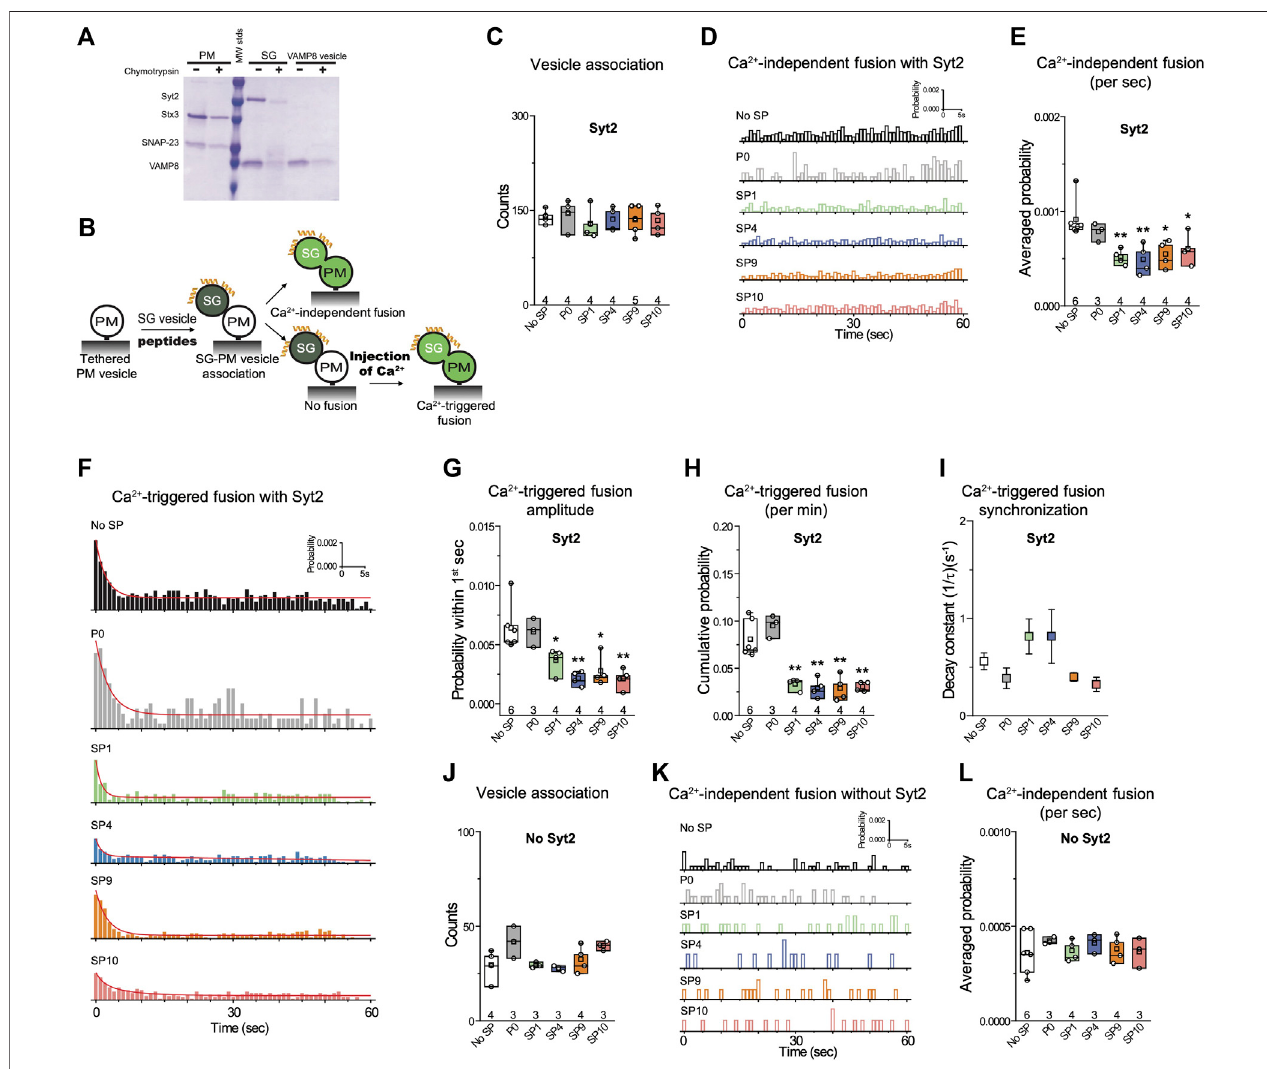
FIGURE 5 | Stapled peptides inhibit Ca 2+ -triggered content mixing with reconstituted airway epithelial SNAREs and Syt2. (A) SDS-PAGE of airway PM and SG vesicleswithreconstitutedairwaySNAREsandSyt2.Achymotrypsindigestwasusedtodeterminetheproperdirectionalityofthereconstitutedmembraneproteins.For details of the reconstitution and lipid compositions, see Methods in (Lai et al., 2022). (B) Schematic of the single vesicle content mixing assay. Airway PM: plasma membrane mimic vesicles with reconstituted airway Stx3 and SNAP-23; SG: secretory granule mimics with reconstituted VAMP8 and Syt2. After SG — airway PM vesicle association, vesicle pairs either undergo Ca 2+ -independent fusion or remain associated until fusion is triggered by Ca 2+ addition. 10 μ M of each speci fi c stapled peptide (yellow) was added together with SG vesicles and was present during all subsequent stages. (C) Effects of stapled peptides on vesicle association. (D) CorrespondingCa 2+ -independentfusionprobabilities. (E) CorrespondingaverageprobabilitiesofCa 2+ -independentfusioneventspersecond(lefttoright:** p =0.0062, ** p = 0.0082, * p = 0.014, * p = 0.034). (F) Corresponding Ca 2+ -triggered fusion probabilities. (G – I) Corresponding Ca 2+ -triggered fusion amplitudes of the fi rst 1-s time binupon500 μ MCa 2+ -injection (G) (lefttoright:* p =0.036,** p =0.0033,* p =0.012,** p =0.0037),thecumulativeCa 2+ -triggeredfusionprobabilitywithin1 min (H) (left toright:** p =0.0017,** p =0.0014,**0.0018,** p =0.0011),andthedecayrate(1/ τ )oftheCa 2+ -triggeredfusionhistogram (I) . (J-L) thestapledpeptideshavenoeffect on vesicle fusion mediated by airway SNAREs alone. (J) Effects of 10 μ M of each of the speci fi ed peptides on vesicle association using the assay described above. (K) Corresponding Ca 2+ -independent fusion probabilities. (L) Corresponding average probabilities of Ca 2+ -independent fusion events per second. Panels C , E , G , H, J, L show boxplots anddata pointsforn (indicated beloweach box plot)independent repeatexperiments( Supplementary TableS1 ):thewhiskers showthe minand max values (excluding outliers), the box limits are the 25th and 75th percentiles, the square point denotes the mean value, and the center line denotes the median. Decay constants(boxes)anderrorestimates(bars)inpanel I computedfromthecovariancematrixupon fi ttingthecorrespondinghistogramscombiningallrepeatswithasingle exponential decay function using the Levenberg-Marquardt algorithm. * p < 0.05, ** p < 0.01 by Student ’ s t-test, compared to the experiment without the stapled peptides.